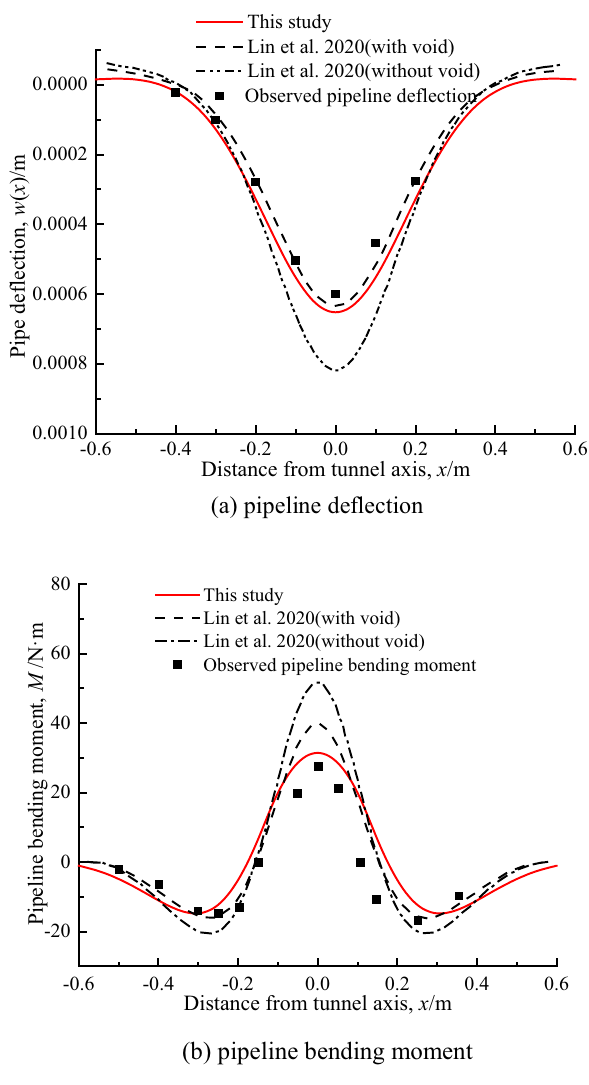
Figure 8. Comparison of calculation results of pipeline deflection and bending moment.